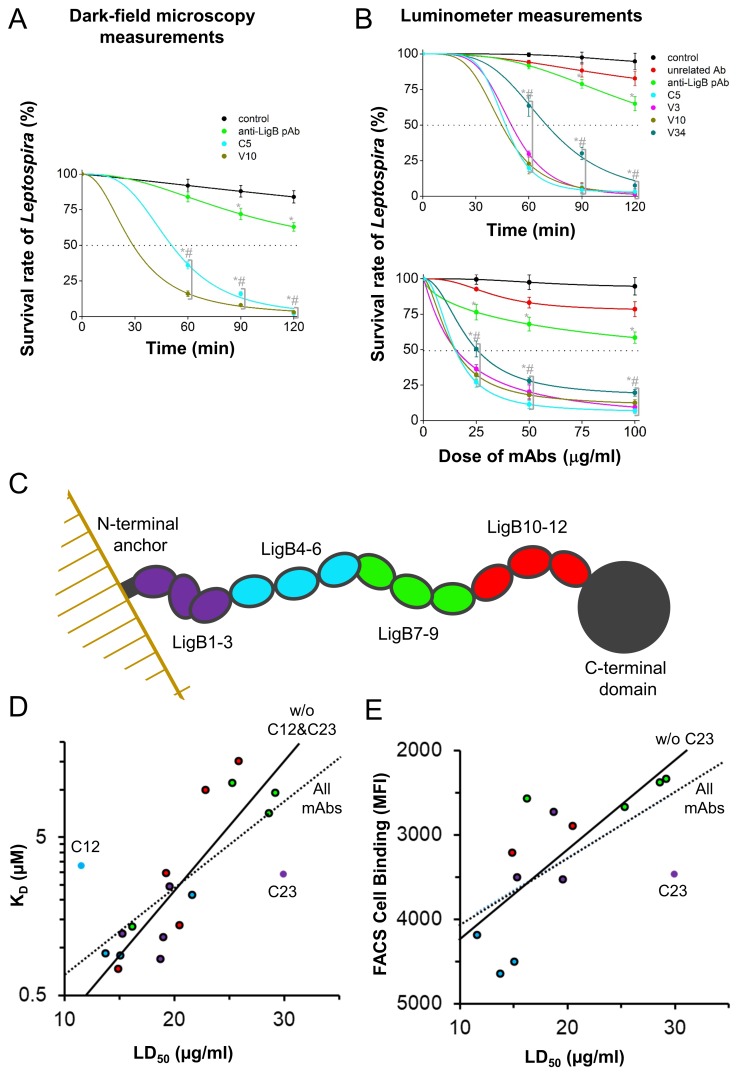
Anti-LigB mAb bactericidal properties.(A, B) Leptospira survival assays were used to assess mAb bactericidal activity. (A) After incubation with individual mAbs, the survival rate of L. interrogans Pomona was observed using dark-field microscopy (B) while the survival rate of bioluminance-producing L. interrogans Manilae was measured using a 96-well luminometer-based assay (full dataset Figure 5—figure supplement 1). Each value represents the mean ± S.D. from three individual trials of two replicates. Statistically significant (t-test; p<0.05) differences were calculated from the comparisons between mAb-treated groups and the control group (*) or between mAb-treated groups and the pAb group (#). (C) A schematic is shown for the SAXS-derived LigB structure. (D) For the set of mAbs, the ELISA antigen binding value is plotted against the LD50. Points for mAbs are colored to match the three domain regions defined in the schematic. Statistically-determined outliers are labelled and data was fit with and without outliers (dashed line, R²=0.508 and solid line, R²=0.773, respectively). (E) For mAbs measured for cell surface binding, the FACS cell binding value is plotted against the LD50 and data is fit with and without outlier, mAb C23 (dashed line, R²=0.312 and solid line, R²=0.466, respectively).